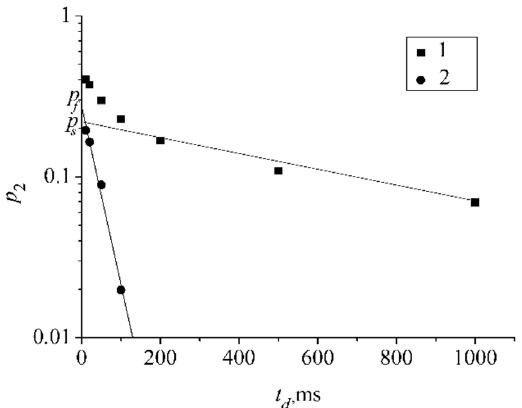
Figure 7. 1—the dependence of part p 2 ( t d ) on diffusion time t d ; 2—the dependence p 2 ( t d ) after subtraction of spin–lattice relaxation component. Reprinted with permission from Ref. [37]. Copyright © 2016 Published by Elsevier B.V.